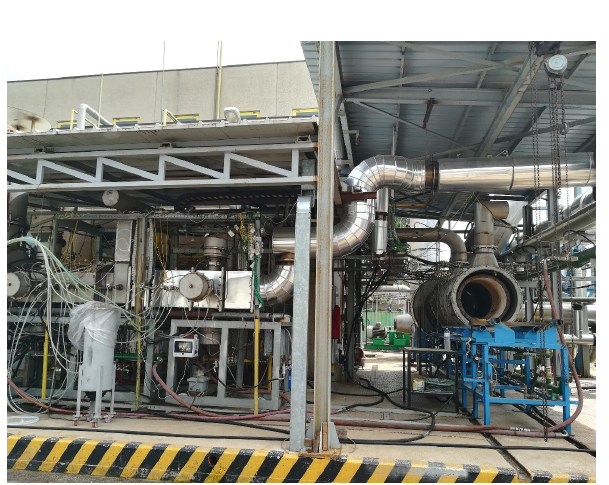
Figure 3. Proposed cone flowmeter.